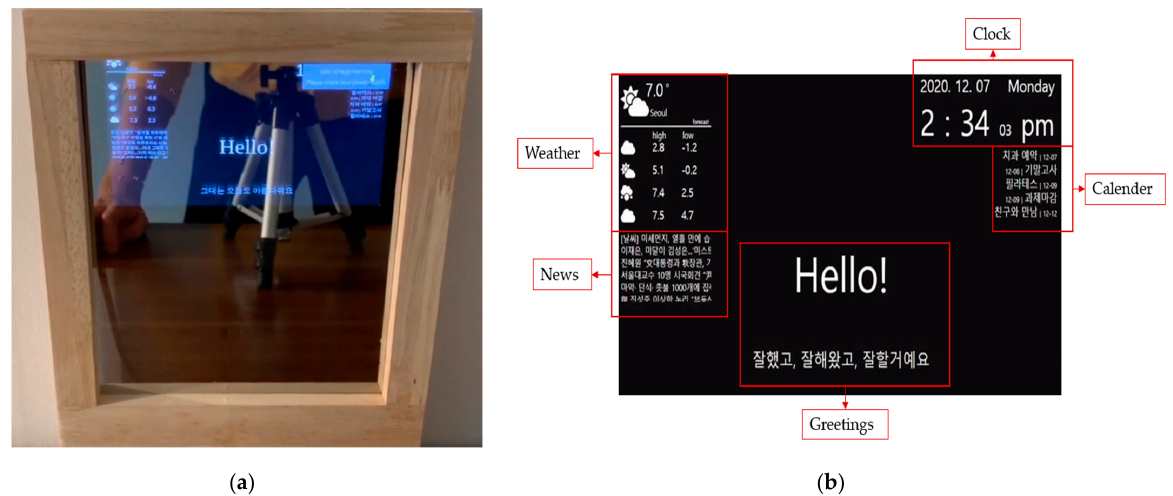
Figure 6. The smart mirror LUX: ( a ) the front view model of LUX, and ( b ) the display view of LUX, including weather, clock, calendar, and news.